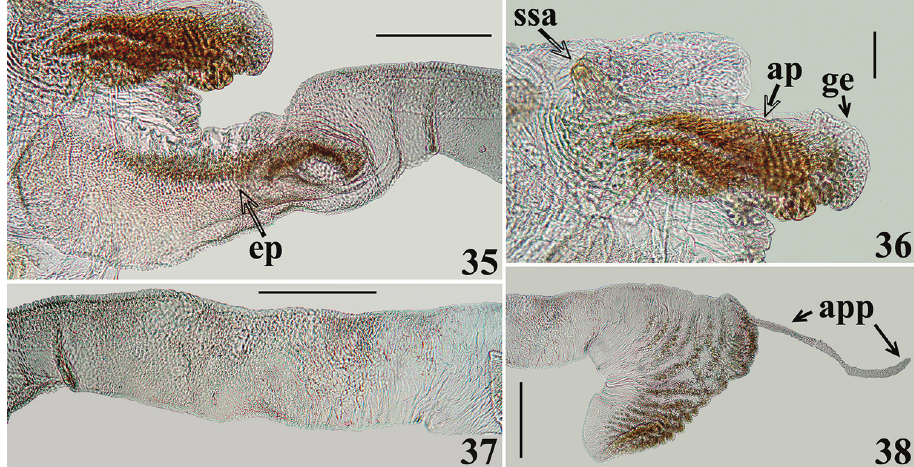
Figures 35–38. Zeraikia zeraikae sp. n., male genitalia, lateral views. 35 apical process and basal portion of subapical tubular projection of endosoma wall. ( ep elongated process inside basal portion of subapical tubular projection of endosoma wall) 36 small subapical and apical processes of endosoma. ( ap apical process; ge globose expansion of endosoma ssa small subapical process) 37–38 endosoma wall